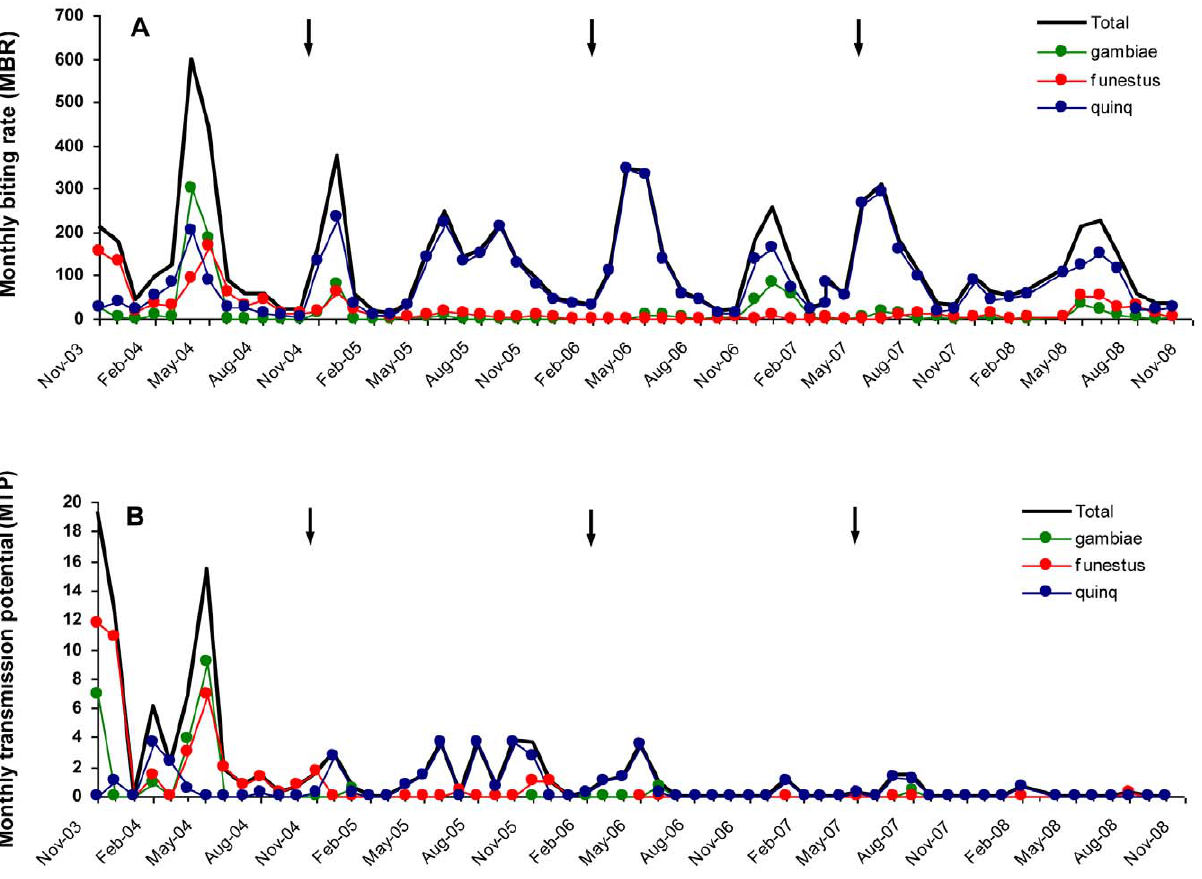
Figure 1. Seasonal variation in monthly biting rate (MBR) and monthly transmission potential (MTP) in Kirare village during the study period (November 2003 to October 2008). MBR, panel A; MTP, panel B. Thick black line = all vector species combined; Thin green line = Anopheles gambiae ; Thin red line = An. funestus ; Thin blue line = Culex quinquefasciatus . Arrows indicate rounds of mass drug administration. doi:10.1371/journal.pntd.0000696.g001 (Table 2, Figure 3A). Anopheline vectors predominated during the pre-MDA period, with An. gambiae and An. funestus comprising 68.5% of the catch, while Cx. quinquefasciatus predominated and comprised 84.1% of the catch during the three post-MDA periods combined (chi-square test, P , 0.001). The overall mean MBR was reduced from 174.3 during the pre-MDA period to 119.8 during the three post-MDA periods. As discussed later, these changes between pre- and post-MDA periods were probably not related to the MDAs.